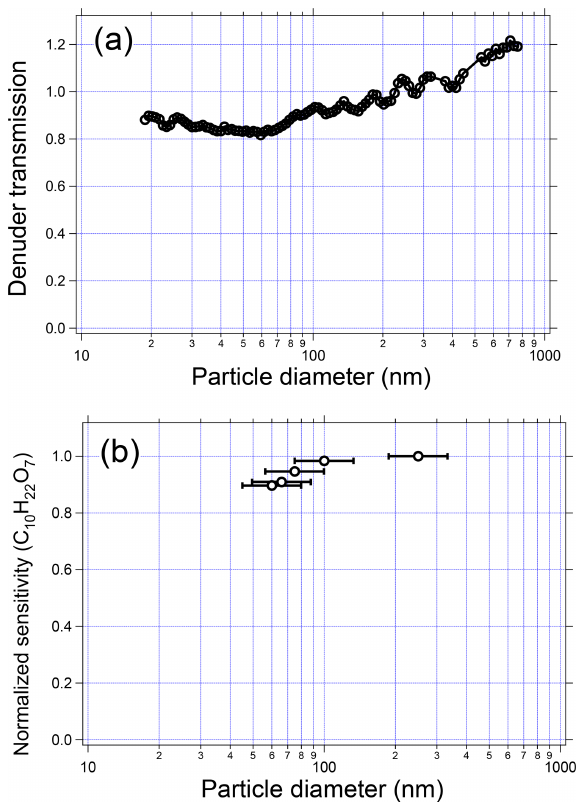
Figure 8. (a) Particle transmission through the denuder as a func- tion of diameter. (b) Measured sensitivity of dipentaerythritol as a function of particle diameter. Error bars denote the mobility diam- eters corresponding to the half-maxima of the polydisperse particle volume